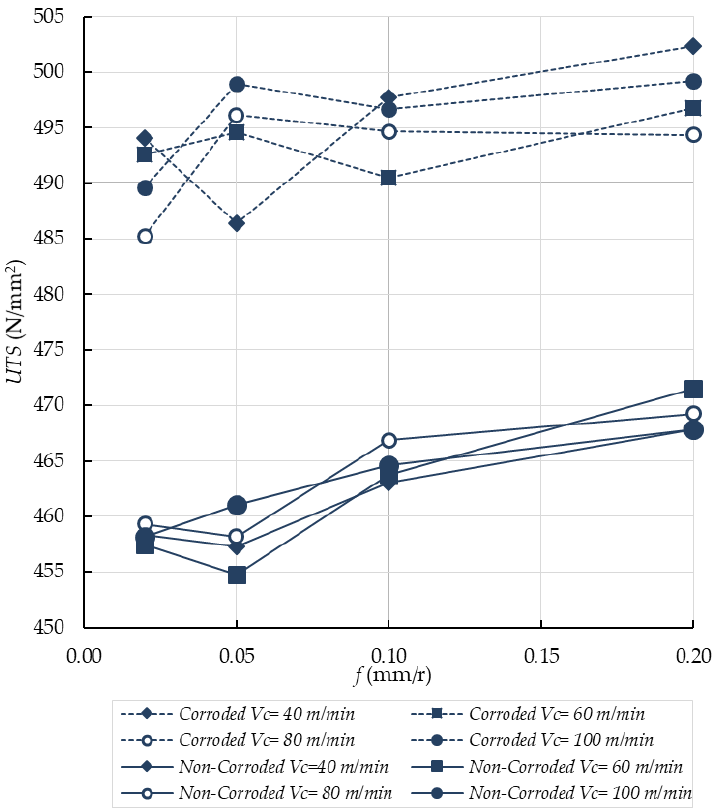
Figure 7. Changes in UTS/ f for all the analyzed cutting speeds. Set I, noncorroded specimens (continuous lines). Set II, corroded specimens (dotted lines).